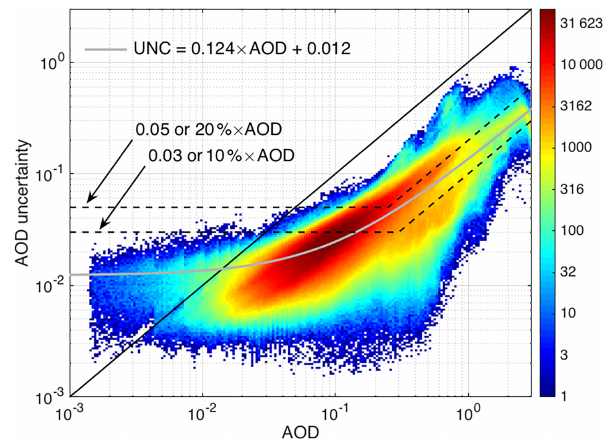
Figure 6. Density plot of AOD uncertainty in log–log space as a function of AOD for the combined January and July 2007 data with ARCI screening. The black line is the one-to-one line, included as a visual guide to illustrate that, over most of the AOD range, the uncertainties are smaller than the AOD values themselves. The gray line is a linear fit to the data. Two dashed lines represent two arbi- trary uncertainty envelopes.